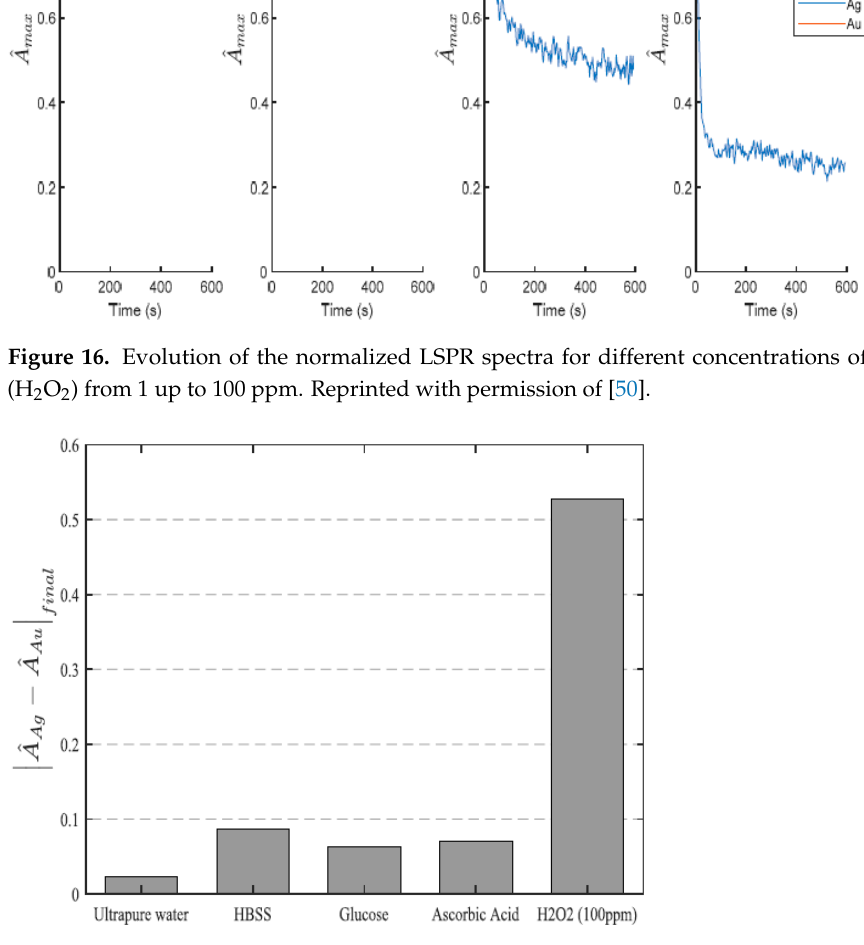
Figure 17. Evolution of the normalized LSPR sensor against different solutions (ultrapure water, Hanks’ Balanced Salt Solution-HBSS) or interfering agents (glucose, ascorbic acid). Reprinted with permission of [50].